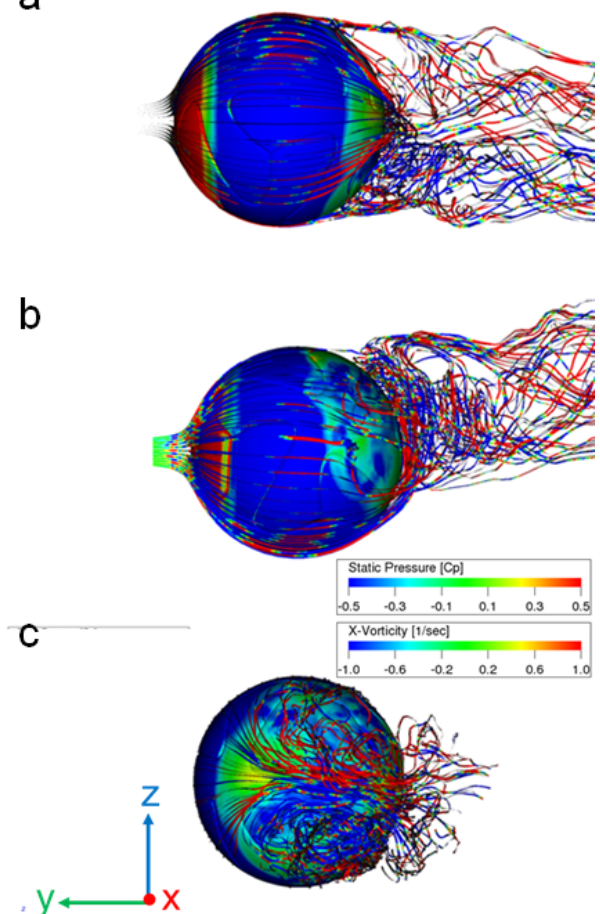
Figure 6. Example of static pressure and x-vorticity observed on streamlines around a spinning soccer ball using CFD from ( a ) side view, ( b ) top view, and ( c ) back view. The asymmetry in the flow direction of the separation points (line) in the abovementioned boundary layers of the ball affected the pressure distribution (Figure 7a,b) and vortex structure, resulting in the side and lift forces acting on the ball [23]. In addition, it is considered that the large- scale counter-rotating vortex pair produced traces of deflection in the separation points and pressure distribution, and the vortex structure may be similar to that of a wing tip [38,39].